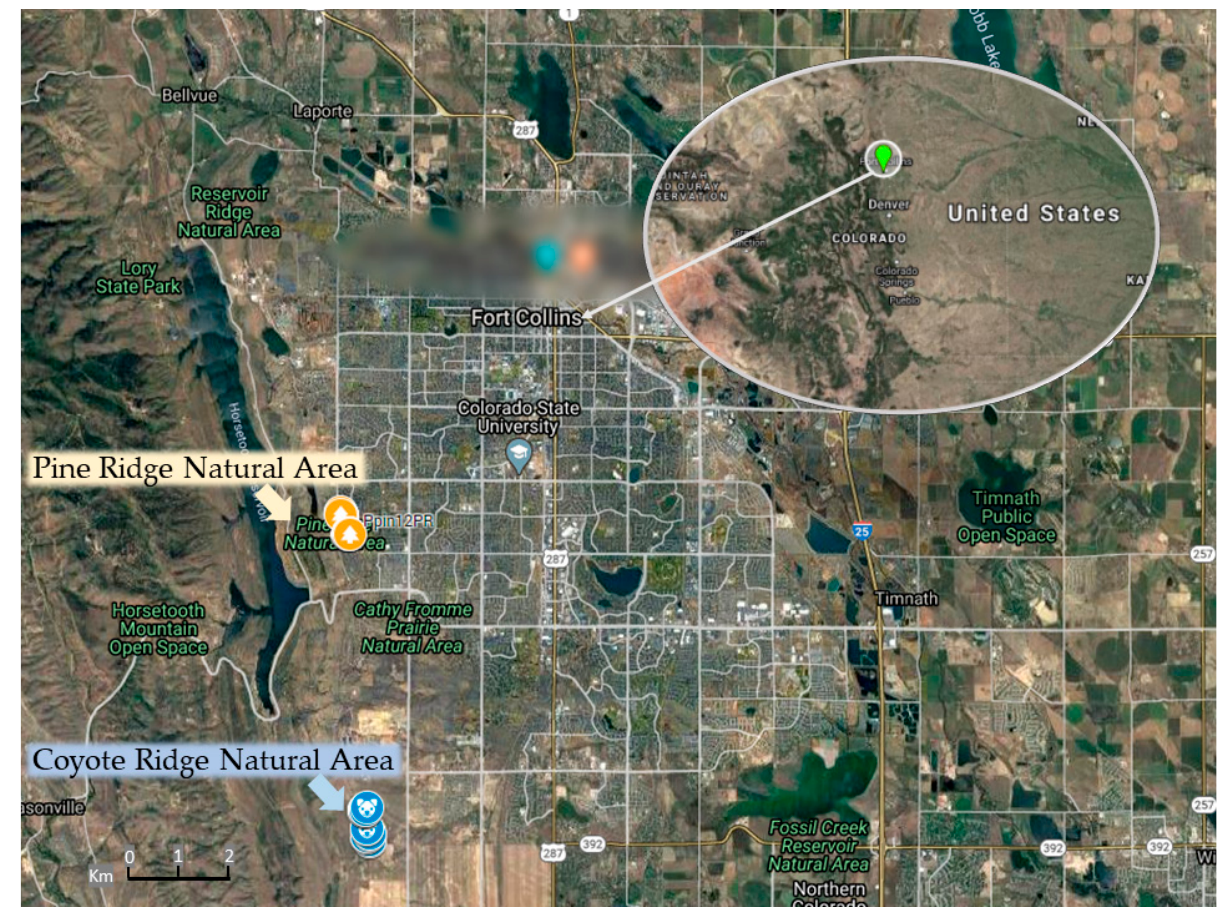
Figure 1. Map depicting the two natural areas investigated, namely the Coyote Ridge natural area (geographic coordinates: latitude, 40°28 ′ 51 ″ N; longitude, 105°07 ′ 31 ″ W) and the Pine Ridge Natural area (geographic coordinates: latitude, 40°32 ′ 32 ″ N; longitude, 105°08 ′ 05 ″ W), near the city of Fort Collins, Colorado/USA.